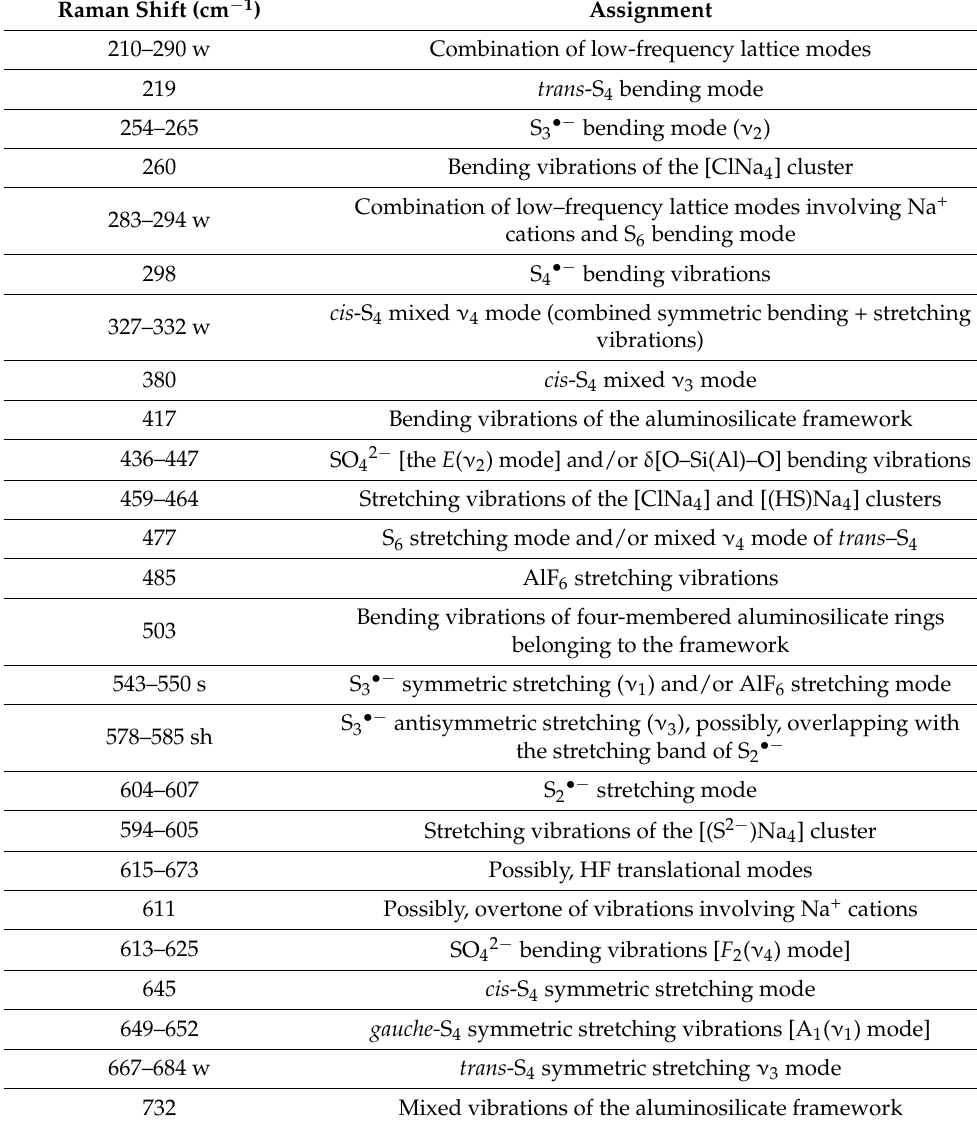
Table 2. Assignment of Raman bands of sodalite-group